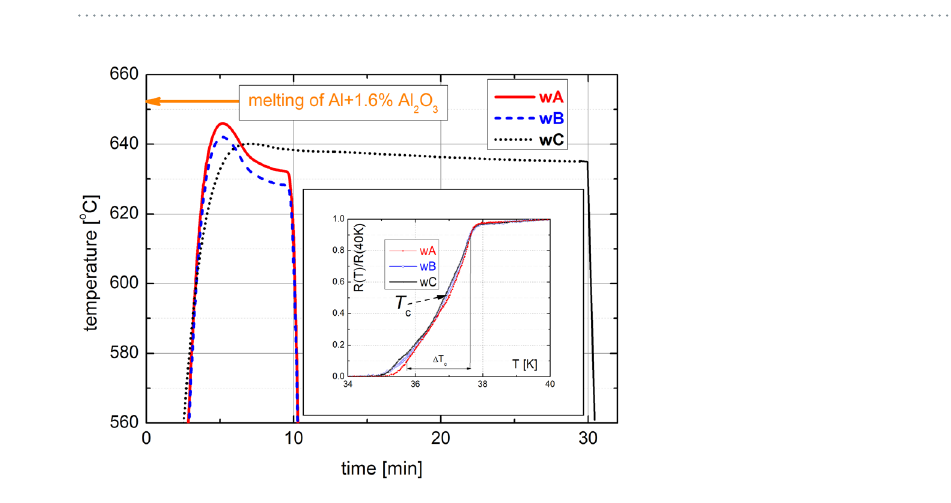
Figure 1. The pattern of final heat-treatments applied for wires wA, wB and wC. The insert shows the resistive transitions of compared wires.